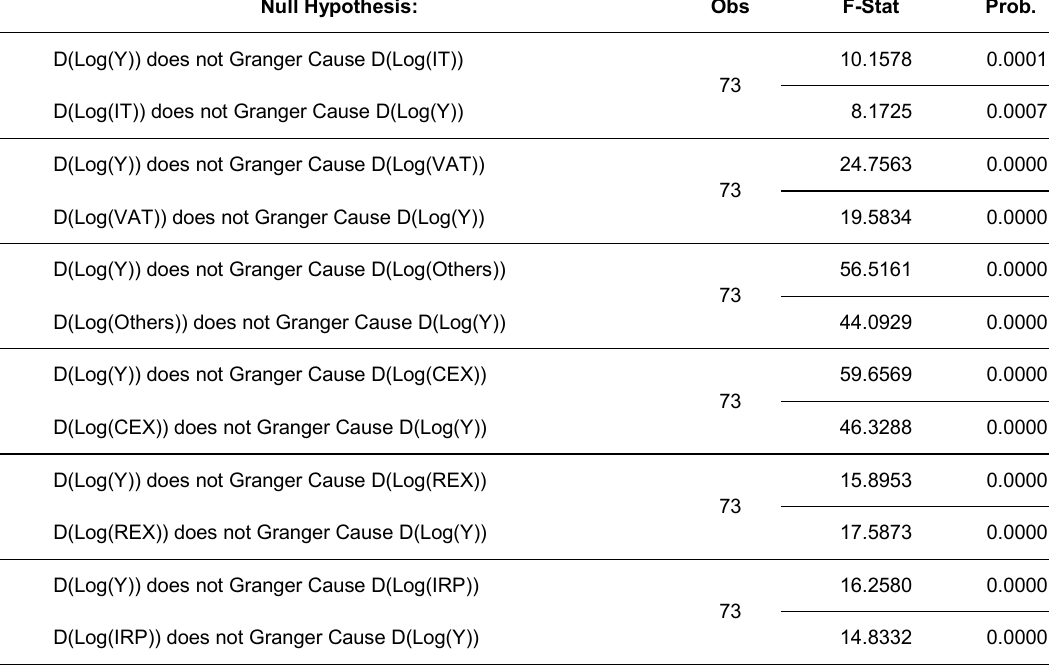
Table 2. Causality Test of Revenue and Expenditure to GDP. Null Hypothesis: Obs F-Stat Prob. D(Log(Y)) does not Granger Cause